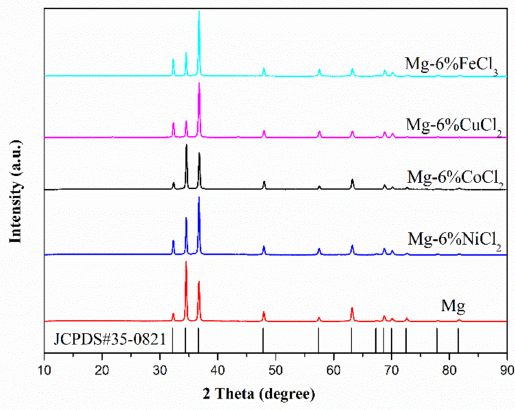
Figure 2. XRD patterns of Mg and Mg-chloride composites after ball-milling.